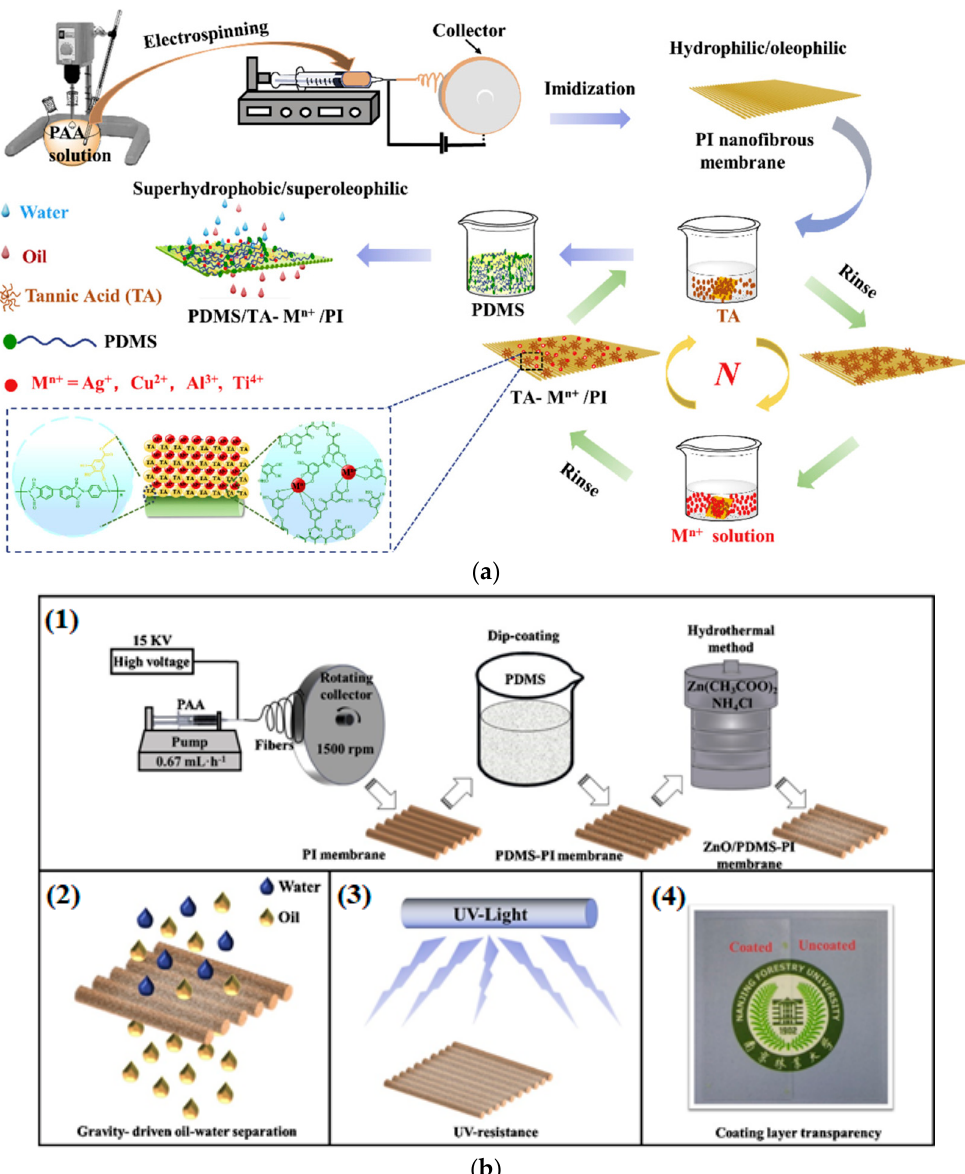
Figure 5. Schematic illustration for the fabrication of ( a ) PDMS/TA-Mn+/PI nanofibrous membrane and the formation mechanism of the PDMS/TA-Mn + coating on the PI nanofibrous membrane (reproduced from [143] with permission of Elsevier, 2019), and ( b ) the ZnO/PDMS-PI membrane. ( 1 ) The preparation process, ( 2 ) the scheme of gravity-driven oily wastewater separation, ( 3 ) the UV-irradiation experiment, and ( 4 ) the transparency of the coating layer (reproduced from [144] with permission of Elsevier, 2019).